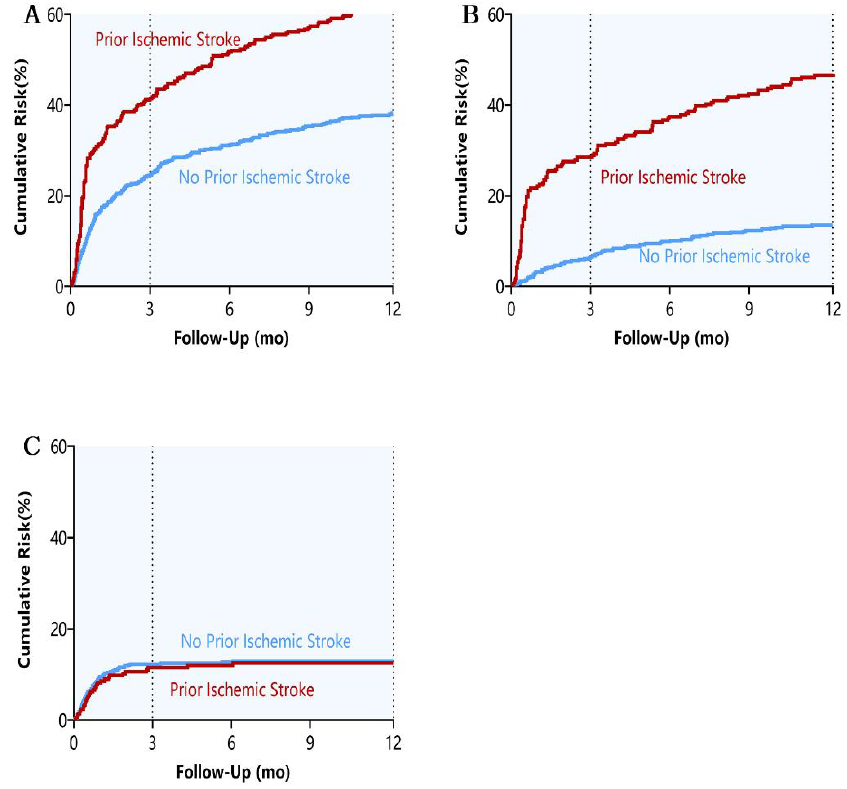
Figure 2. ( A ) All-cause death or readmission; ( B ) Non-HF readmission; ( C ) All-cause death. Table 3. Patient characteristics and multivariate analysis of factors for 3-month all-cause readmission or death in elderly HF patients with a history of ischemic